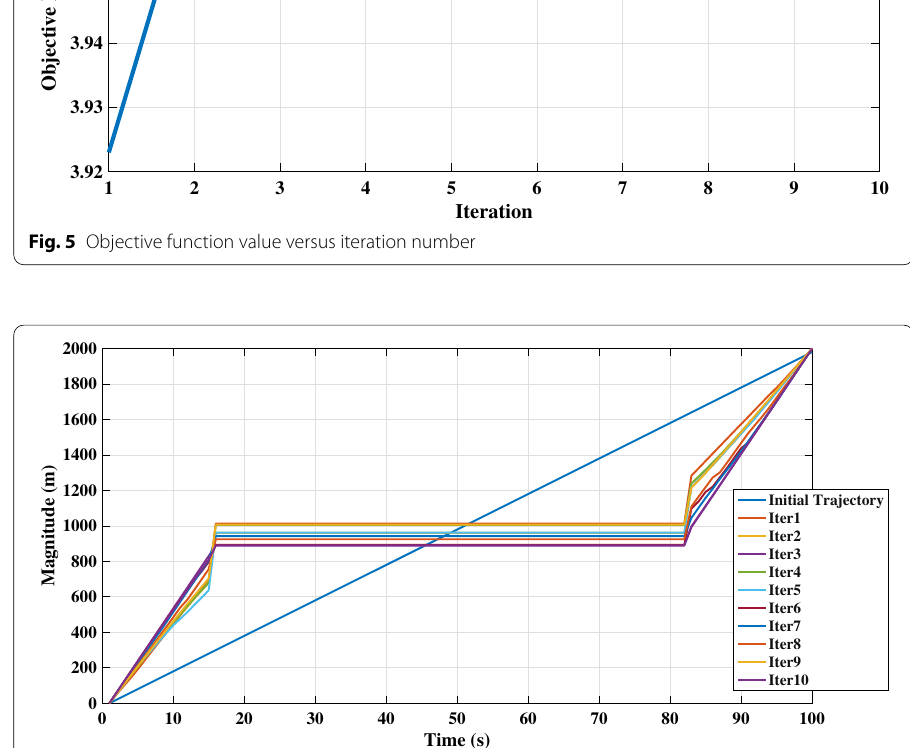
Fig. 6 X -axis of optimized trajectory with fixed power